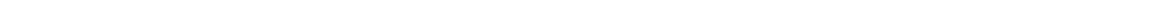
Fig. 5 sE-cad-positive exosomes activate the NF κ B pathway. a Top network identi fi ed by IPA. Gene signatures of HUVEC incubated with IgG pre-treated exosomes and HECD-1 pre-treated exosomes. b NF κ B reporter assay of HUVEC treated with exosomes (25 μ g mL − 1 ) in the presence or absence of E- cadherin neutralizing antibodies, HECD-1 (100 μ g mL − 1 ) or VE-cadherin neutralizing antibodies, BV9 (10 μ g mL − 1 ). c Western blot analysis of the subcellular localization of NF κ B subunits in HUVEC treated with exosomes (25 μ g mL − 1 ) in the presence or absence of E-cadherin neutralizing antibodies, HECD-1 (100 μ g mL − 1 ). d Tube formation assay of HUVEC treated with exosomes (25 μ g mL − 1 ) in the presence or absence of Bay11-7082 (Bay) (10 μ M). Upper: Representative images of HUVEC tube formation assay. Lower: Quanti fi cation of the percentage change of the number of branching points. Bar, 100 μ m. e Coimmunoprecipitation of NF κ B subunits and β -catenin ( β -cat) in HUVEC with or without exosomes treatment (25 μ g mL − 1 ). f NF κ B reporter